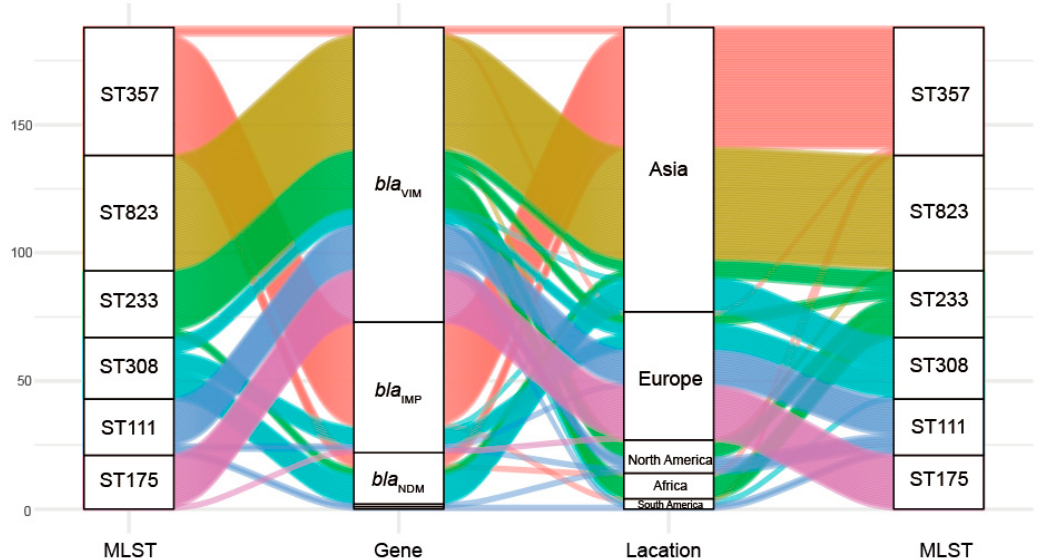
Figure 3. Associations of MLST with antibiotic resistance and geographic locations for the carbapenemase-producing P. aeruginosa isolates.